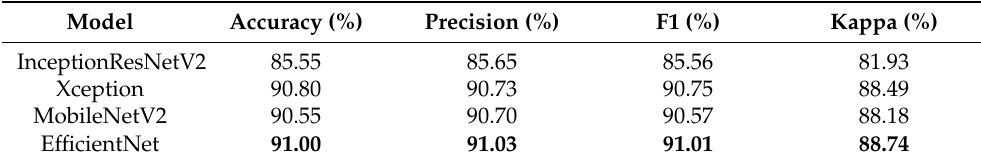
Table 6. Comparison of different CNN networks for Task